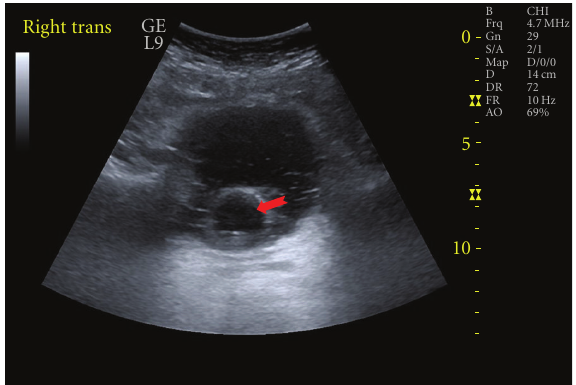
Figure 4: Follow-up ultrasound of urinary bladder after inserting a 16 French Foley catheter with 20 mL balloon. The balloon of Foley catheter was located within urinary bladder (arrow), thus confirming correct placement of Foley